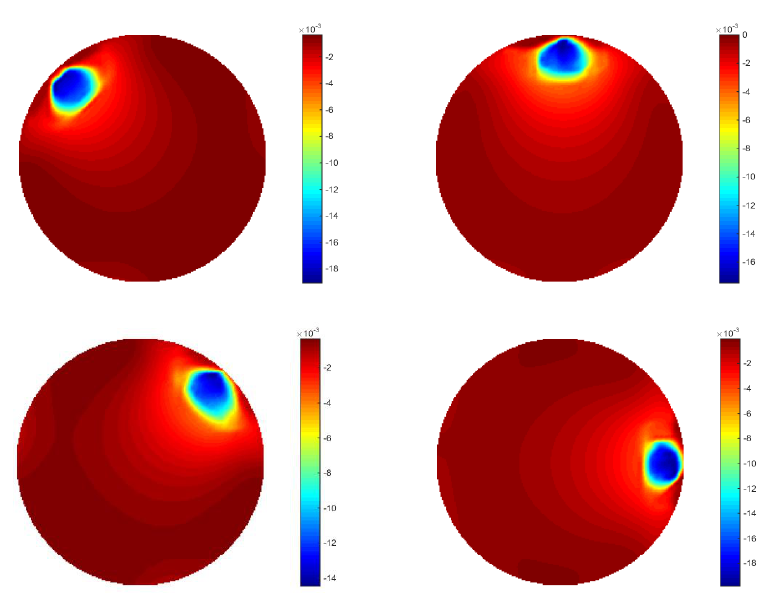
Figure 3. Reconstructed images of inclusion in the simulation test using Temporal TV: The movement path of the inclusion in the simulation test was a circle, where 8 images are selected to show how was the movement of the inclusion within the domain. Each of the sub-graph displaying the location of the inclusion at that time-step.